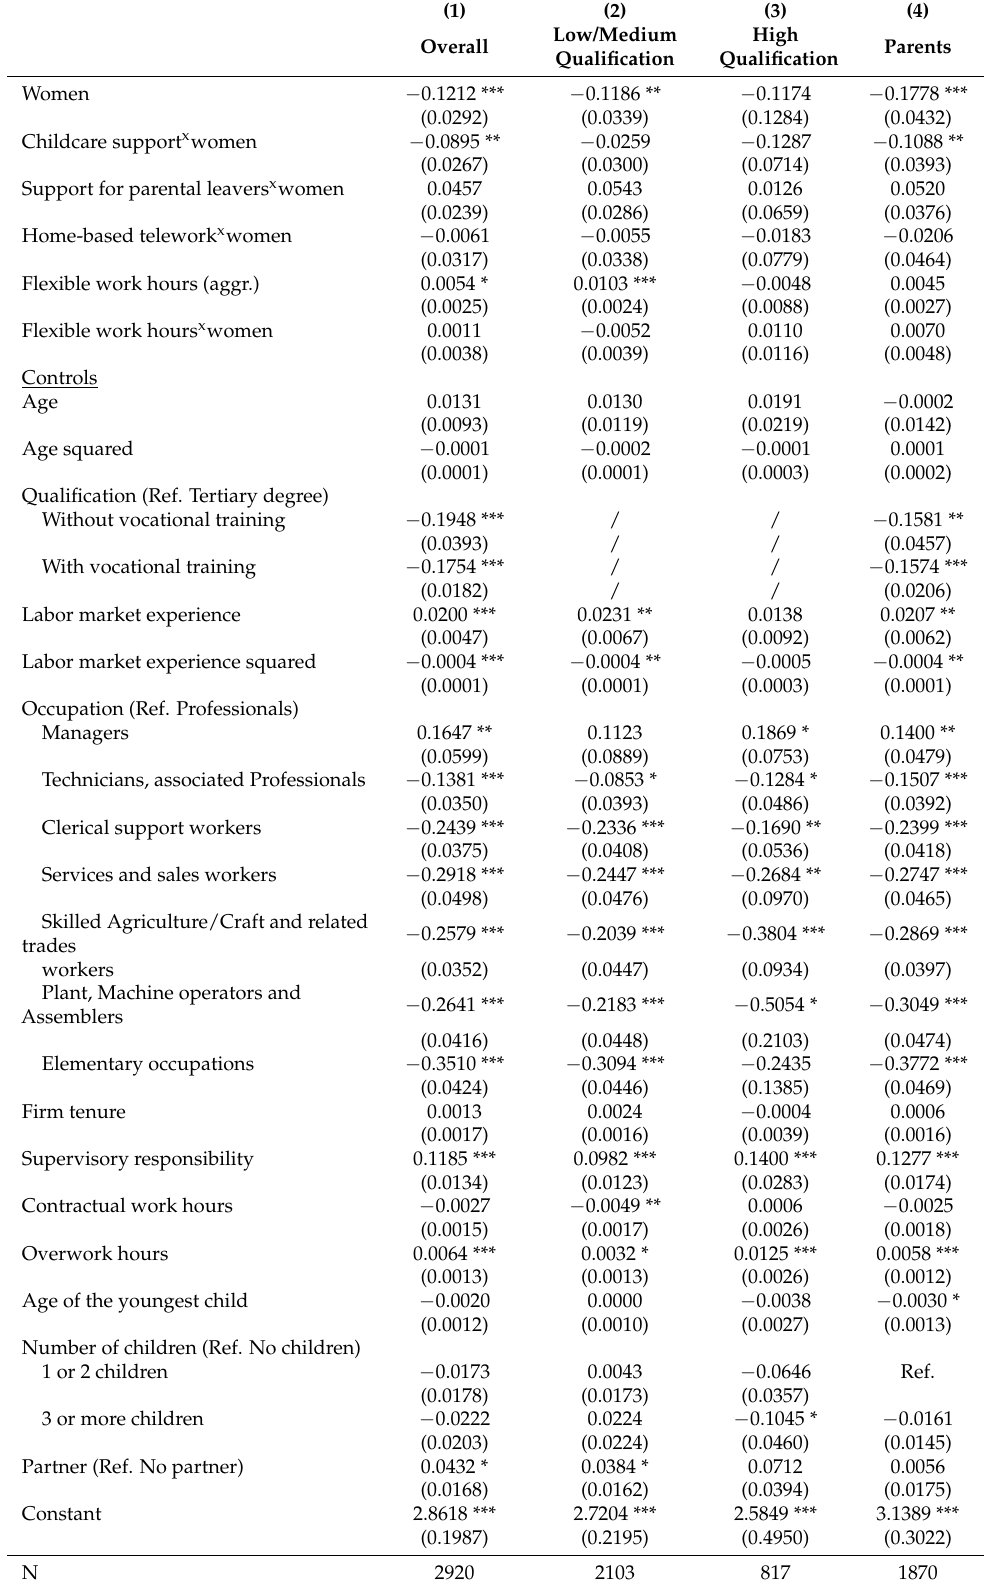
Table A9. The association of WLM and log hourly wages within establishments without EQM including controls (extended version of Table 5, step